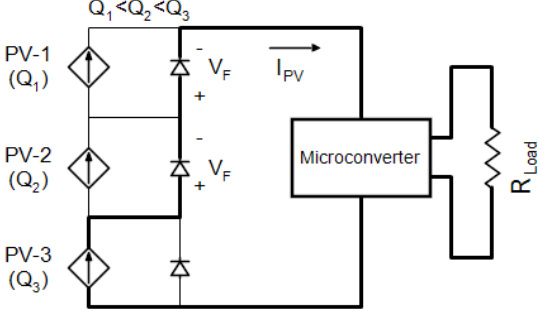
Figure 10. Operation of bypass diodes in a PSC.